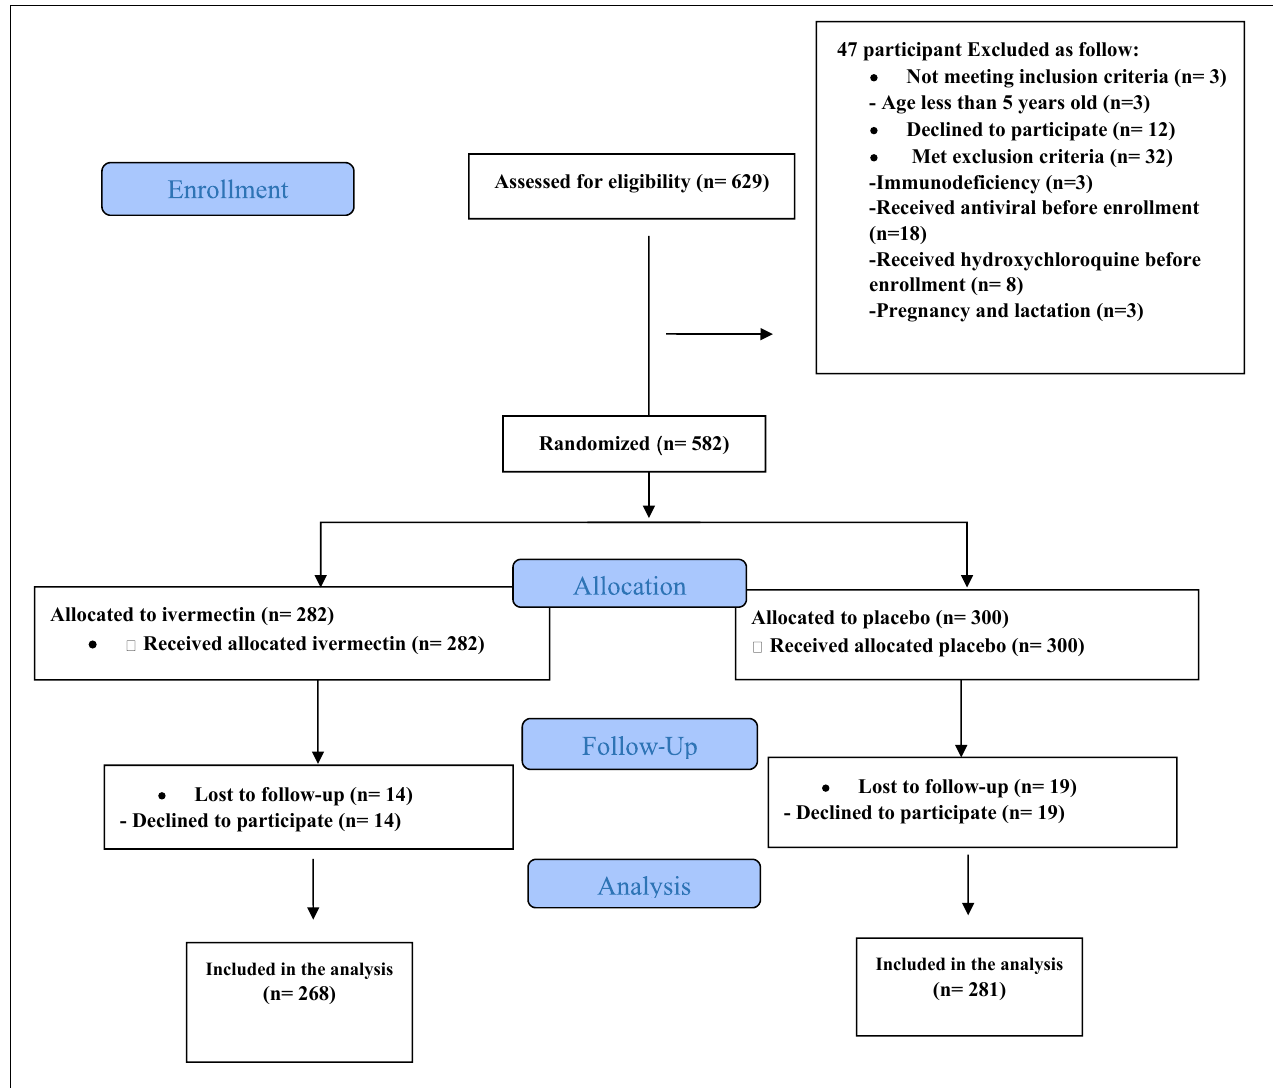
FIGURE 3 | Enrollment, allocation, follow up and assignment of